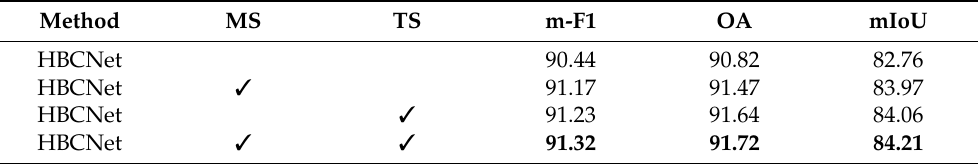
Table 6. Results of different TTA methods for the Vahingen dataset. MS means multi-scale inputs and TS means transpose operations. The values in bold are the best.